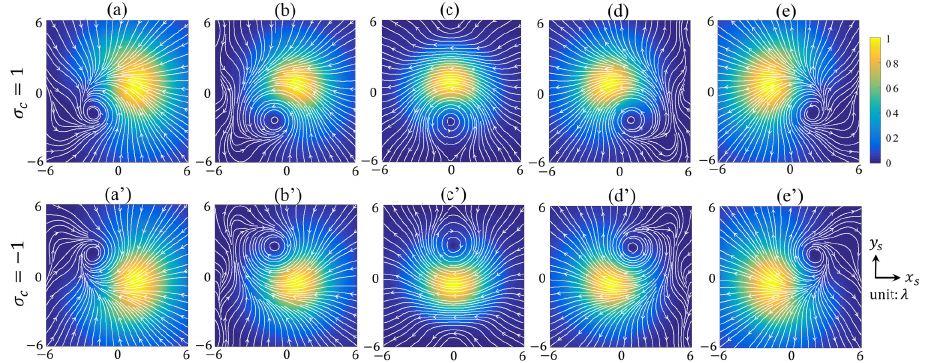
Figure 3. The transverse energy flux s xy along the propagation direction. Here, ( a , a’ ) z s = − 4 λ , ( b , b’ ) z s = − 2 λ , ( c , c’ ) z s = 0, ( d , d’ ) z s = 2 λ and ( e , e’ ) z s = 4 λ . In all plots: a = 0.5 w 0 , f = 2 mm, w 0 = 2 mm and α = 60 ◦